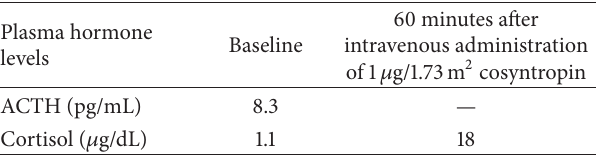
Table 2: ACTH stimulation test